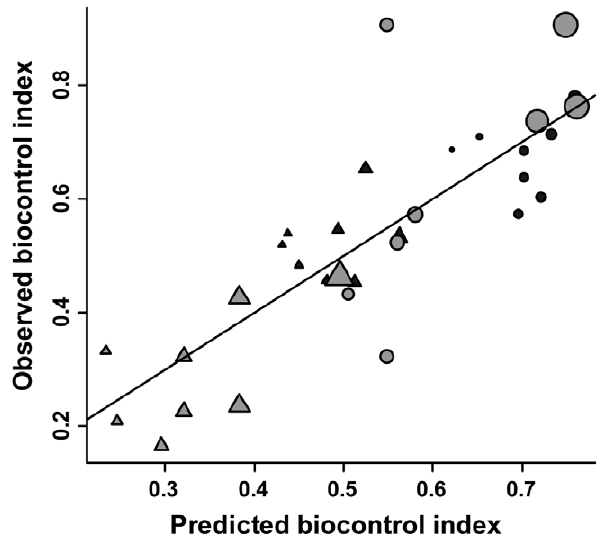
Figure 2. Observed versus predicted biocontrol index. Gray symbols represent sites in Wisconsin and black symbols represent sites in Michigan. Triangles represent corn sites and circles represent grassland sites. Symbol size represents the proportion of the landscape in grassland, where the smallest symbol represents 0.09 and the largest represents 0.70. The solid diagonal line represents unity.